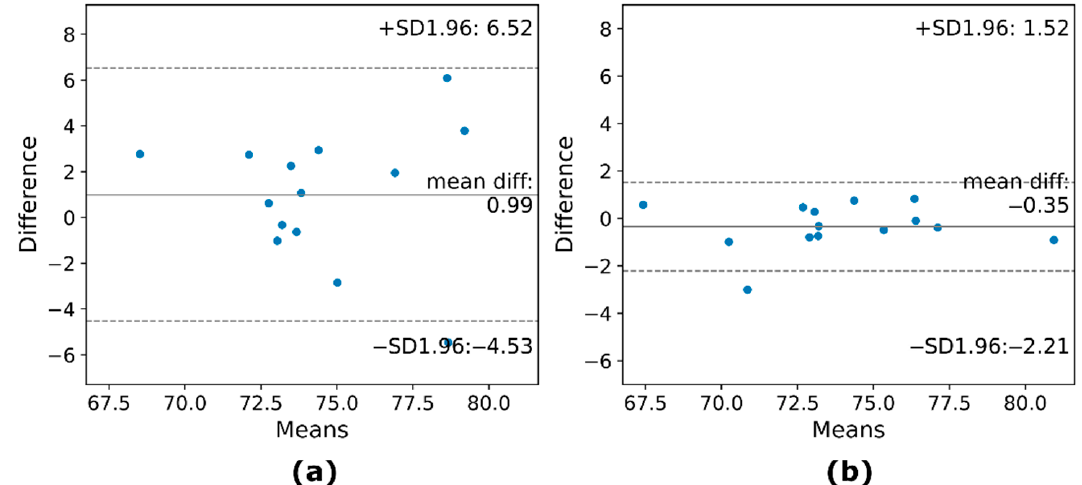
Figure 4. Examples of Bland–Altman plots of the reliability across trials for TSI max of participants belonging to the group 2 (G2): ( a ) between sessions (bias = 0.99, 95% CI = − 4.53 to 6.52) ( b ) and within sessions (bias = − 0.35, 95% CI = − 2.21 to 1.52). The within-session trial comparison ( b ) shows a lower dispersion around the mean compared to between-session trial comparison ( a ).